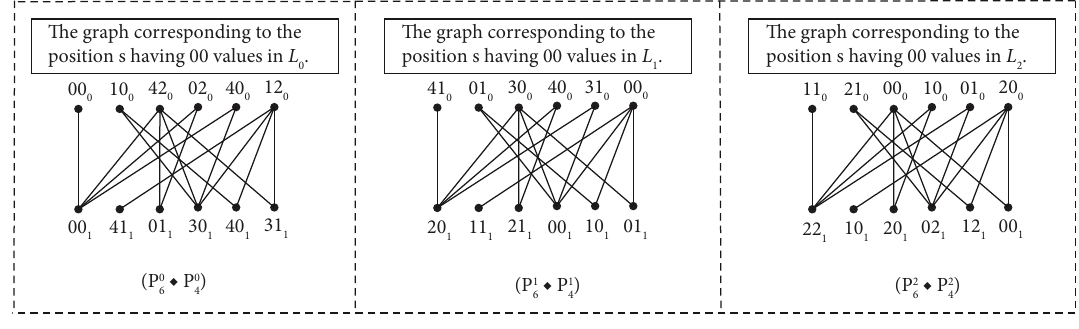
Figure 3: Tree mutually orthogonal half-starters corresponding to the vectors w s ( P s